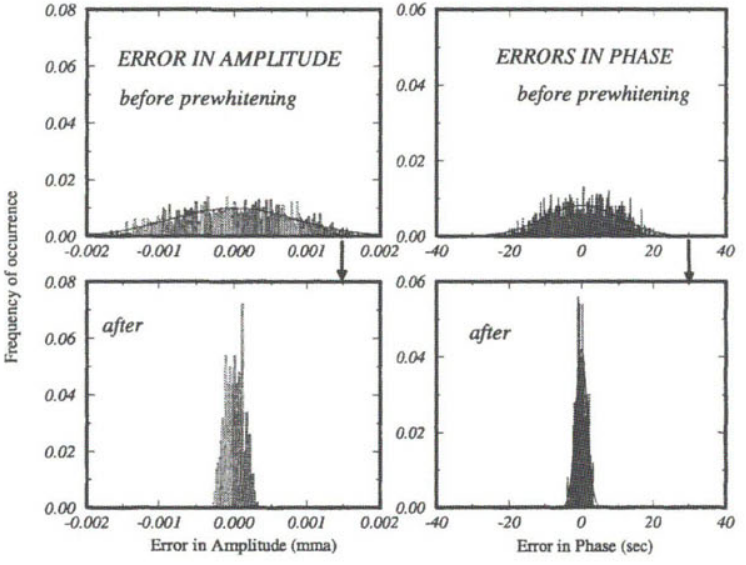
Fig. 6. Efficiency of the prewhitening. Figure shows the error distri- butions in calculation of amplitude (left) and phase (right) of a pulsation mode before (top) and after (bottom) prewhitening of the